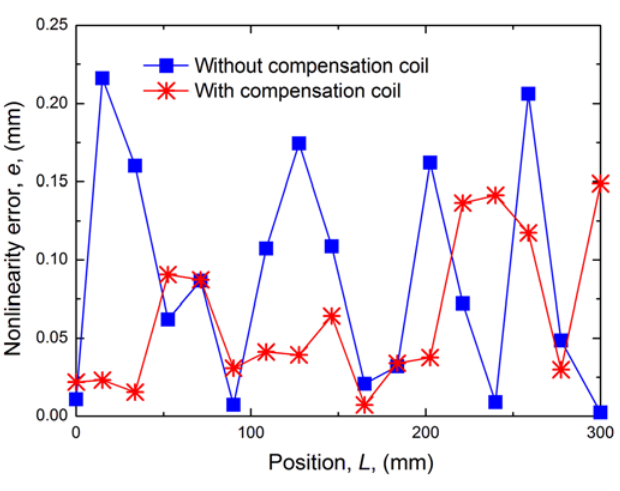
Figure 7. Comparison of linear